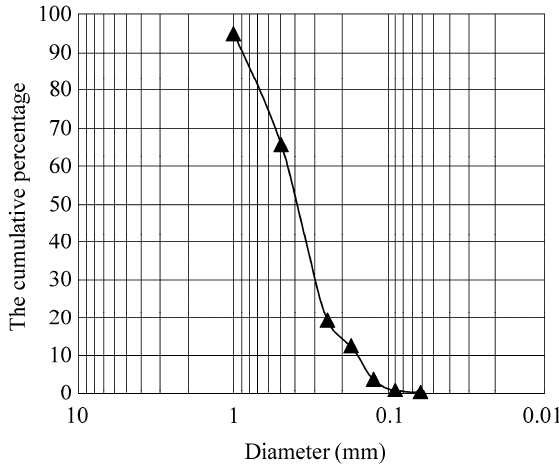
Fig. 5. Fine sand grading Fig. 4 Coarse sand grading curve. Fig. 5 Fine sand grading curve.